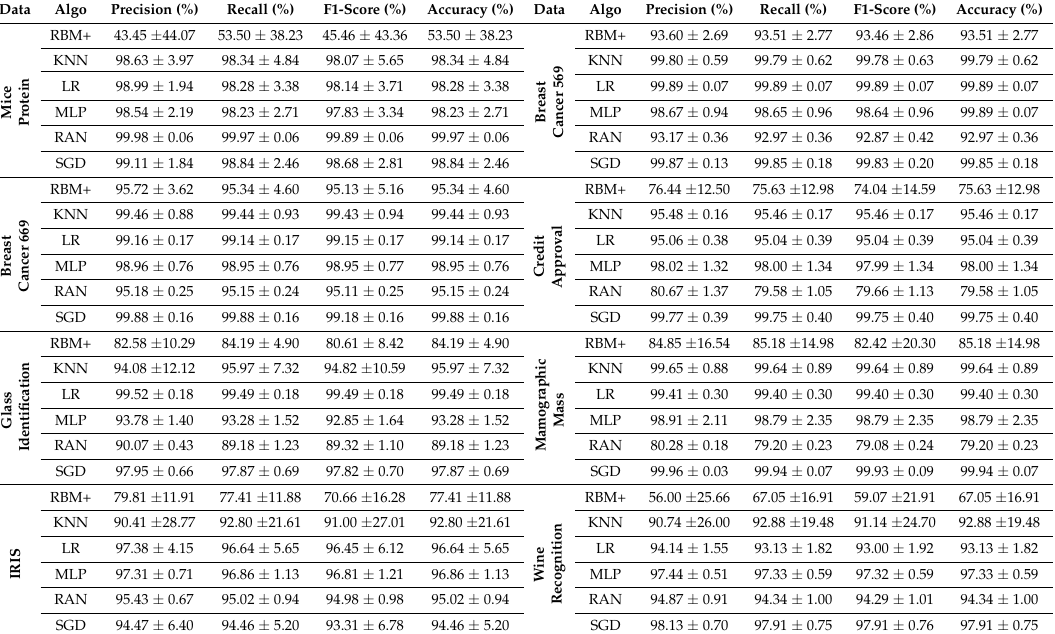
Table 6. RANs comparison with eight datasets belonging to different domains.